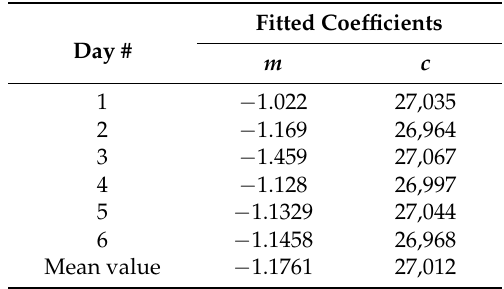
Figure 8. ( a ) Measured temperature variation (top) and fluctuation of oscillation frequency (bottom) for the uncompensated oscillator over 24 h; ( b ) Linear fit of the oscillation frequency versus temperature. Table 2. Look-up table (LUT) used for temperature